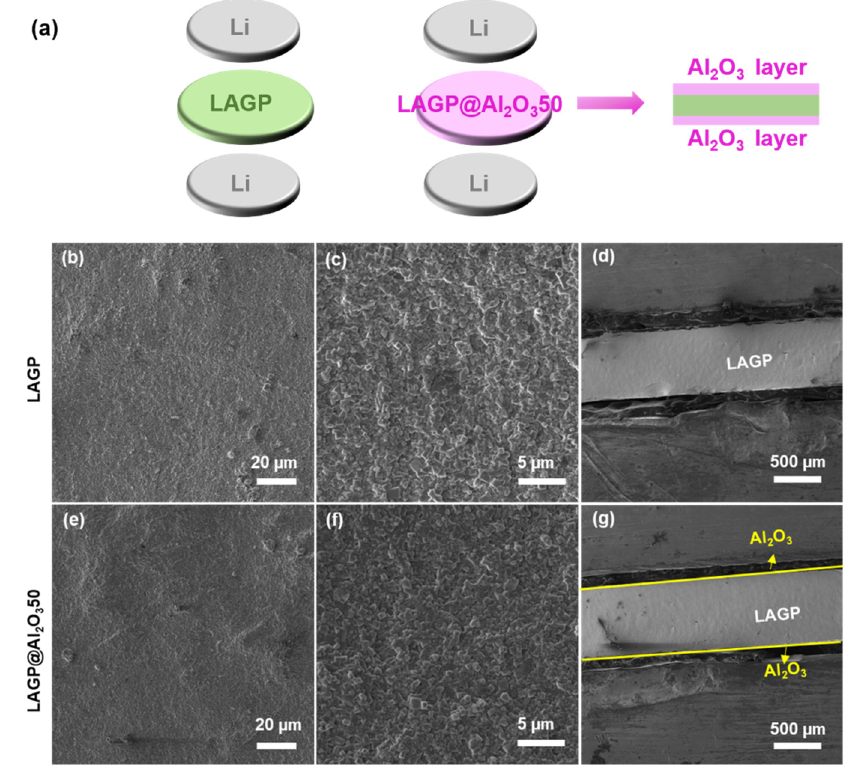
Figure 3. ( a ) Schematic illustration of Li/LAGP/Li and Li/LAGP@Al 2 O 3 /Li cell configurations, top-view and cross-sectional SEM images of ( b – d ) LAGP and ( e – g ) LAGP@Al 2 O 3 50.